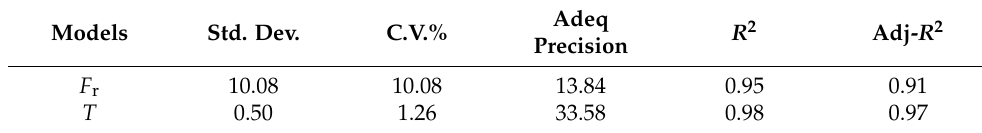
Table 5. Model summary statistics for resultant force ( F r ) and temperature ( T )